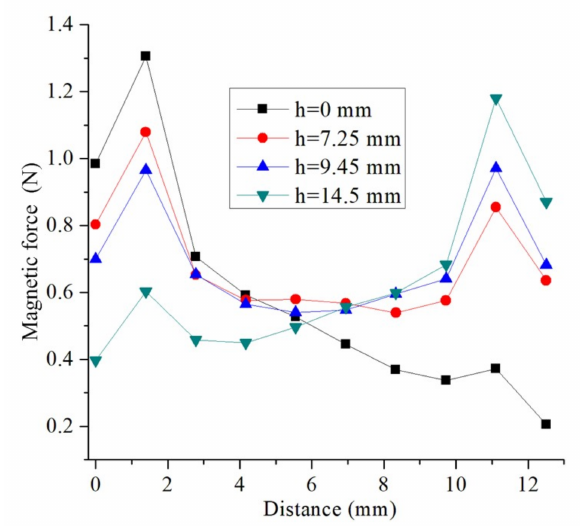
Figure 8. The relative position of the sample affected by the magnetic force on path